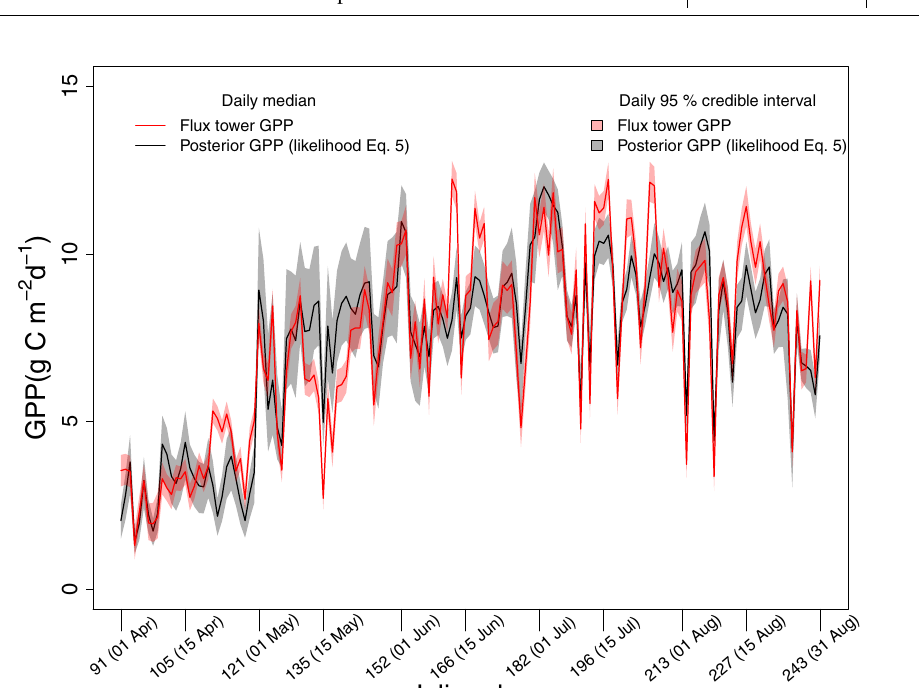
Before calibration Experiment 1 (with likelihood function of Eq. 5) Experiment 1 (with likelihood function of Eq. 6) Experiment 2 (with likelihood function of Eq. 5)